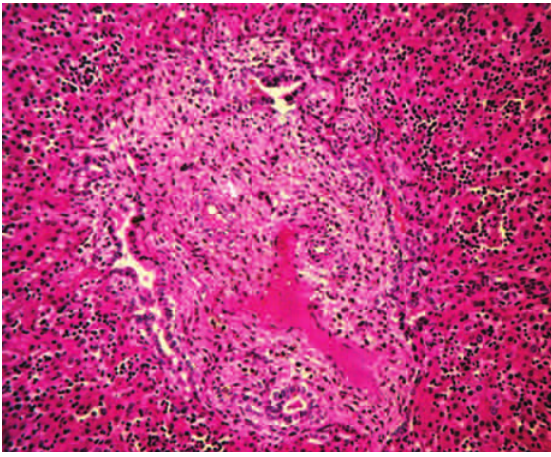
Figure 3. Microscopy of the fibrous proliferation of the liver (Hematoxylin eosin stain x100). A – Fibrous proliferation of the